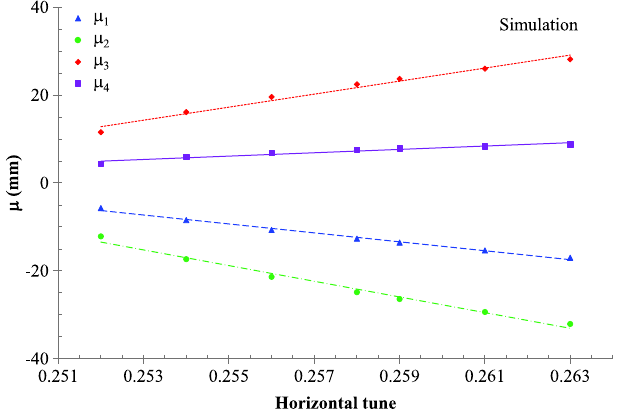
FIG. 12. The position of the fixed points as a function of the horizontal tune is plotted. The numerical model of the PS ring has been used. Such a model has been built starting from measurements of tunes as a function of momentum offset.